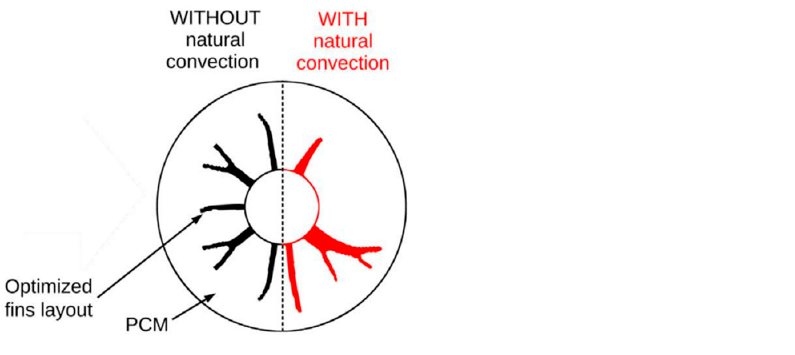
Figure 8. Topology optimized fins with and without natural convection [72]. (Permission to reproduce from Ref.